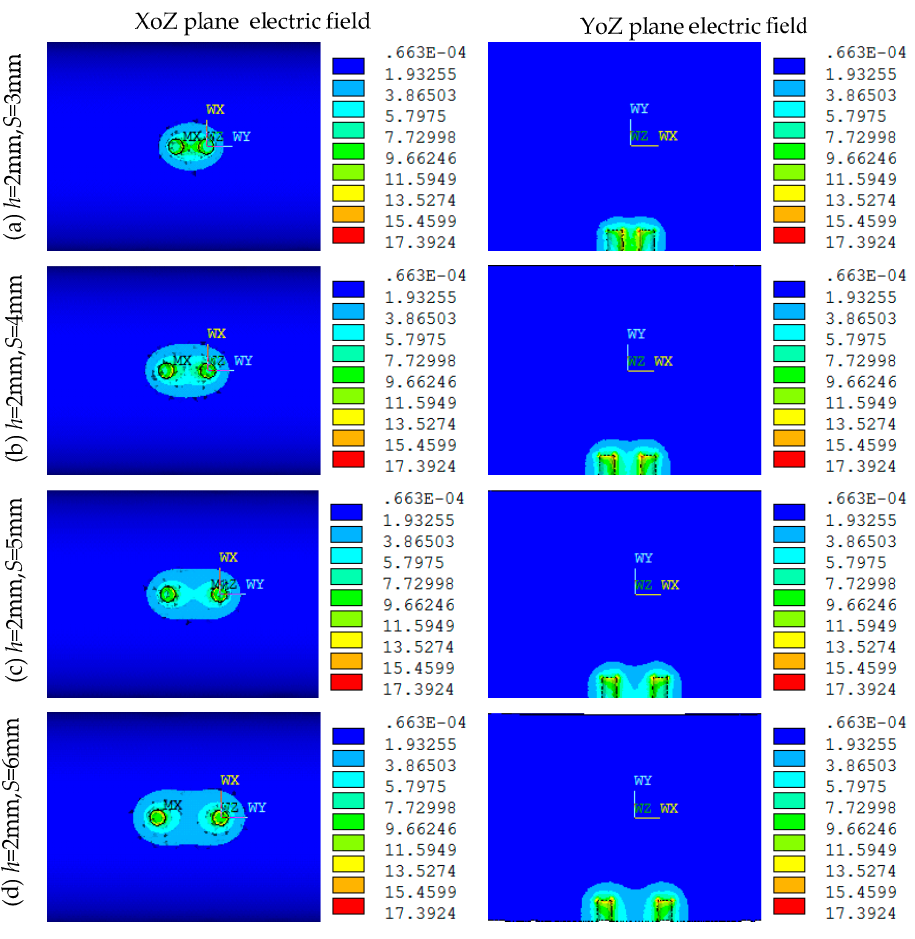
Figure 6. Electric field distribution under different S ( D = 20 mm, h = 2 mm, d = 1.5 mm): ( a ) S = 3 mm; ( b ) S = 4 mm; ( c ) S = 5 mm; ( d ) S = 6 mm.